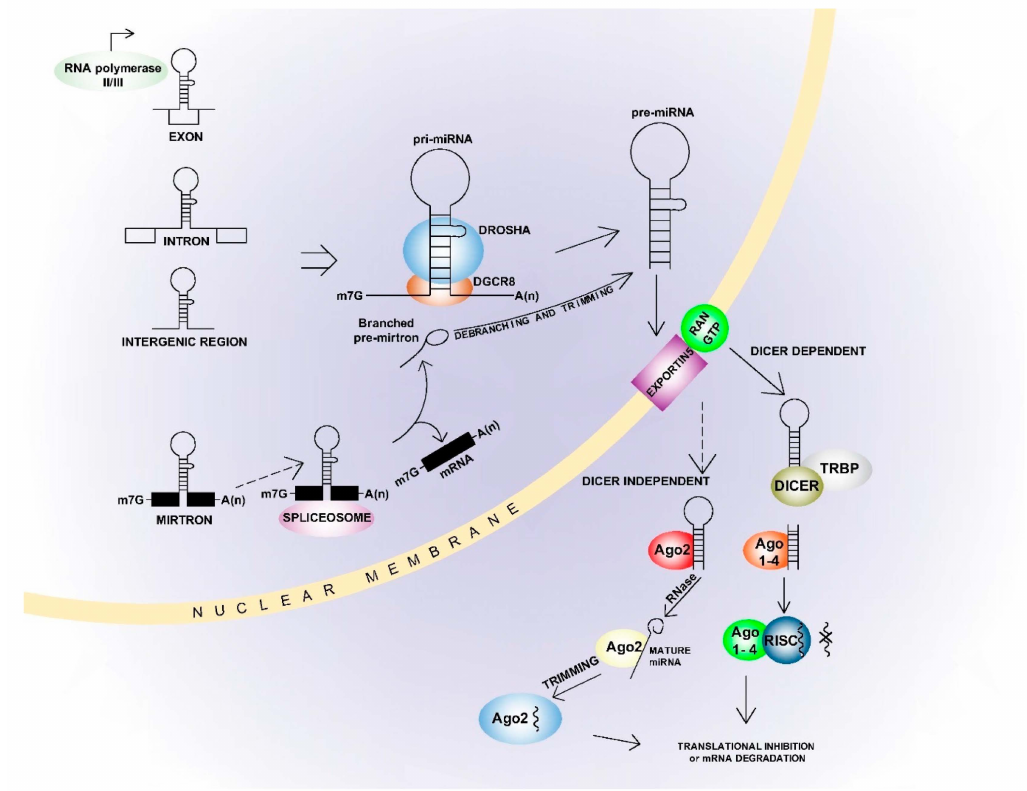
Figure 1. Canonical and non-canonical miRNA biogenesis pathways. miRNAs are usually transcribed by polymerase II; but some are also transcribed by polymerase III as in those miRNAs from clusters spread within Alu repeats. The primary transcript (pri-miRNA) in canonical biogenesis has typical loop structure after transcription and it can it be hundreds of base pairs long. The pri-miRNA is recognised by DGCR8 protein and this combines with Drosha enzyme to form a